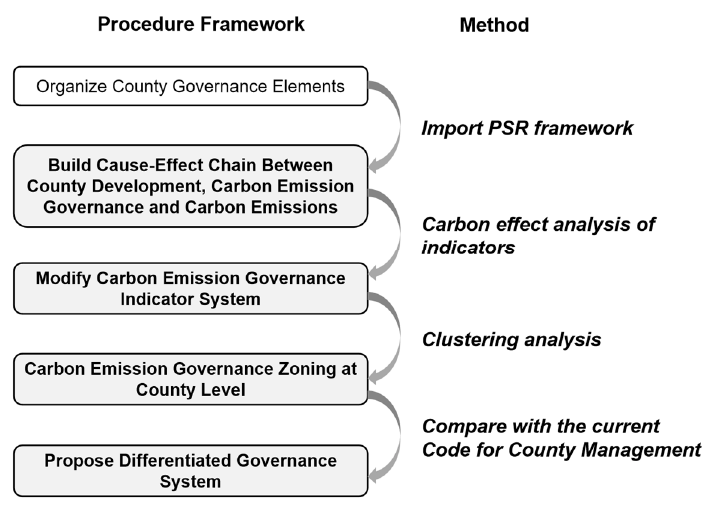
Figure 1. Research Figure 1. Research framework.